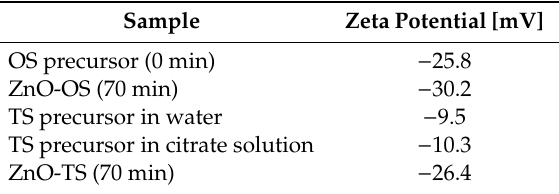
Figure 7. FT-IR spectrum of OS products at 0, 30, and 60 min. Table 2. Zeta potential values for various samples.